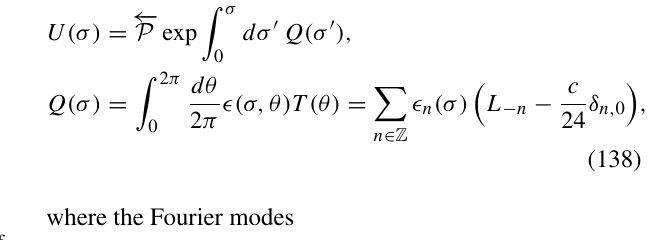
Fig. 14 Complexity of subregions of the vacuum state as a function of the interval size. This figures makes it apparent that the leading contri- bution to complexity grows linearly with the subsystem size which is the aforementioned volume law . Figure taken from [74]. Here the mass was fixed to be small mL = 0 . 01 in order to mimic the results of a